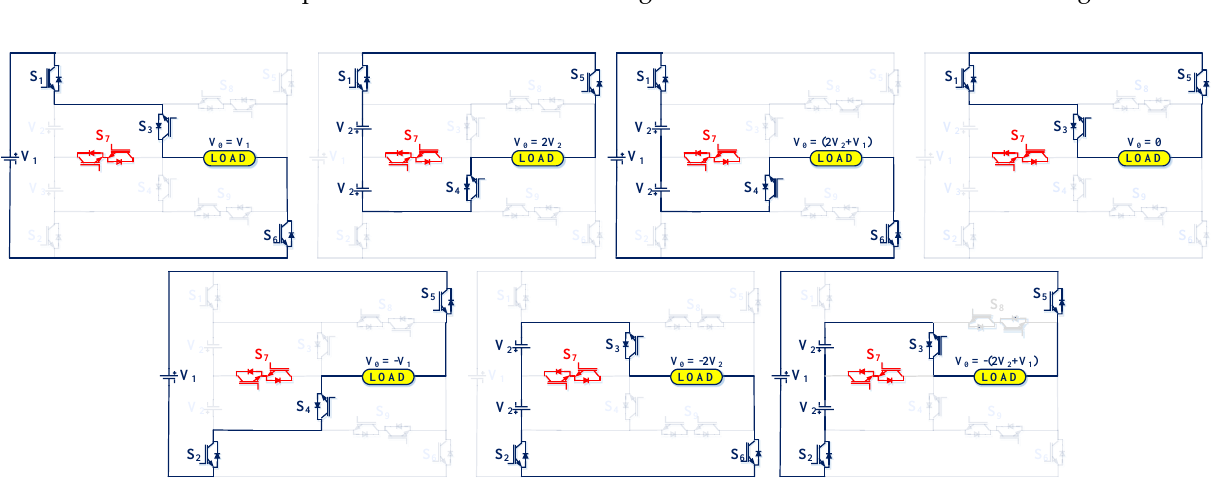
Figure 5. Faulted S 7 and following conduction states.